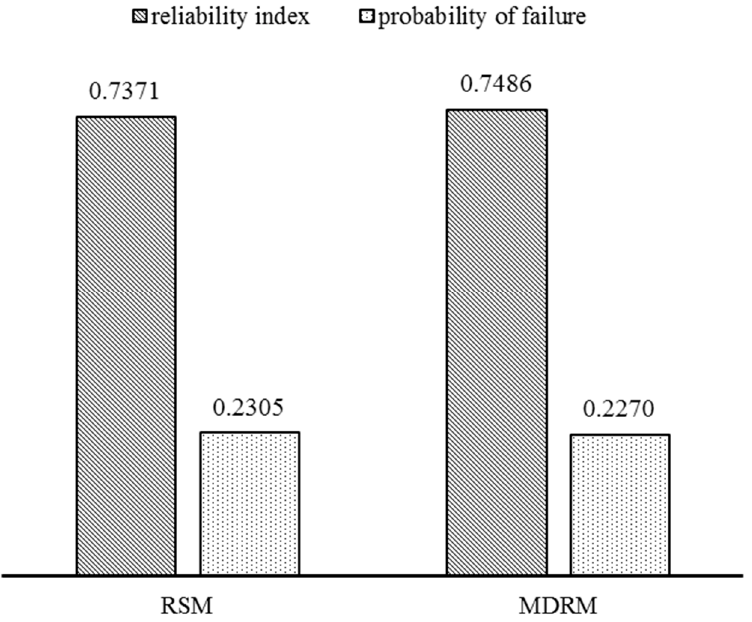
Figure 11. The comparison of reliability analysis using the proposed method and